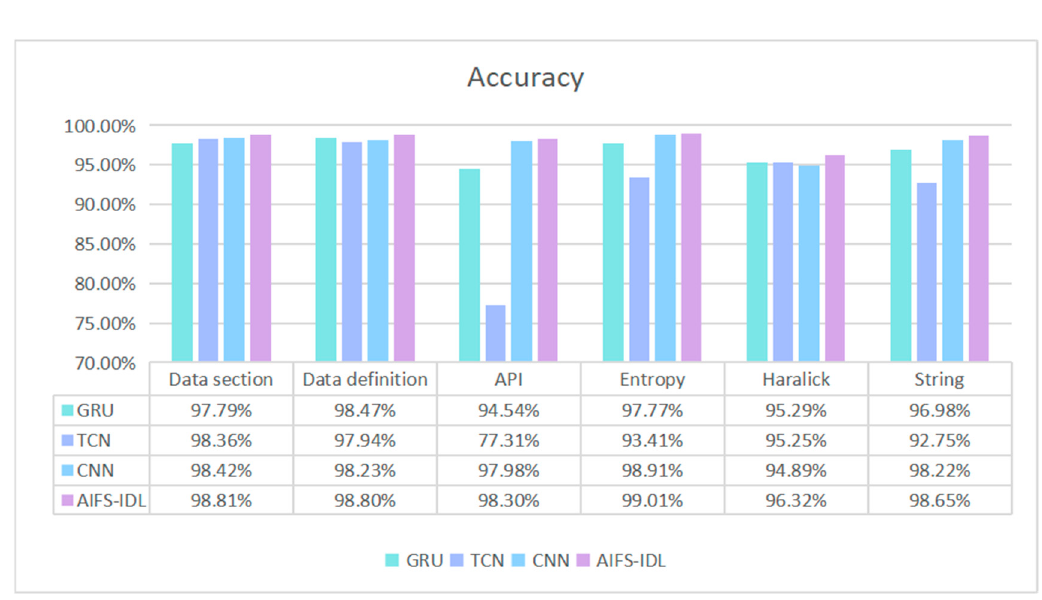
Figure 9. Accuracy of single feature.